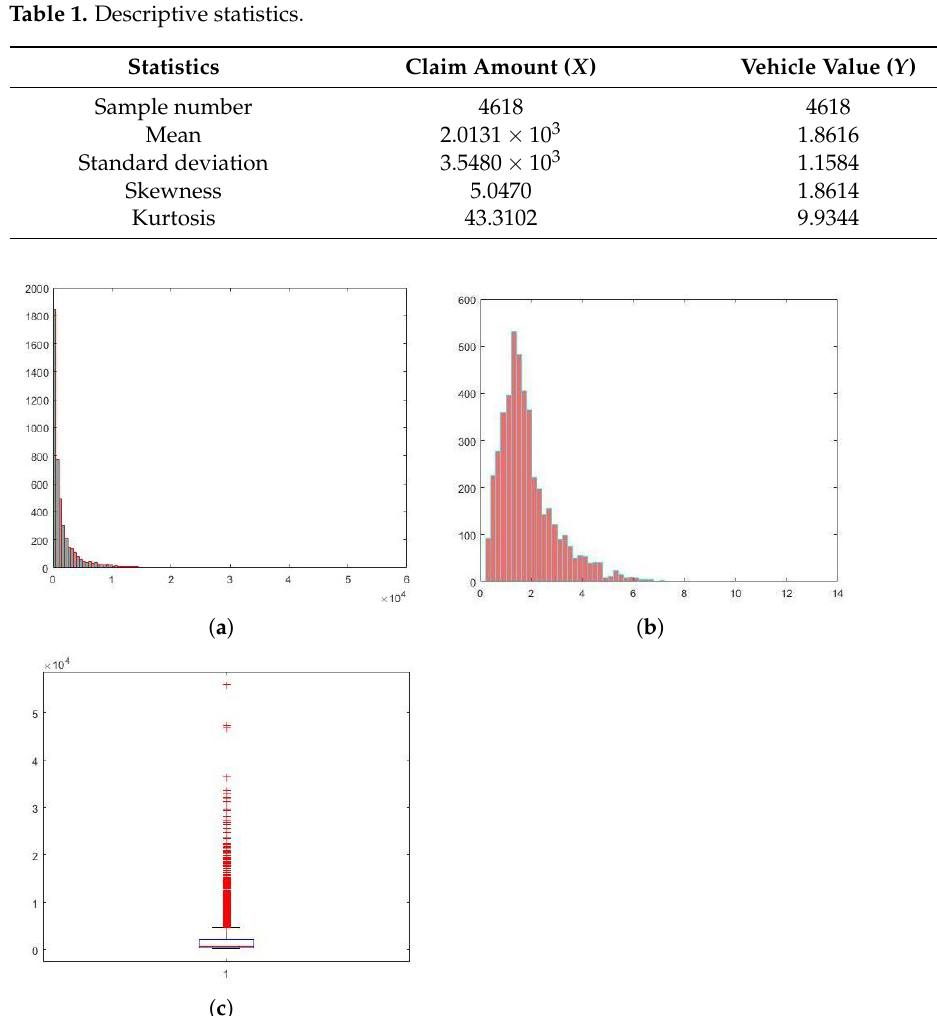
Figure 3. ( a ) Histogram of insurance claim amount; ( b ) histogram of vehicle value; ( c ) box plot of insurance claim